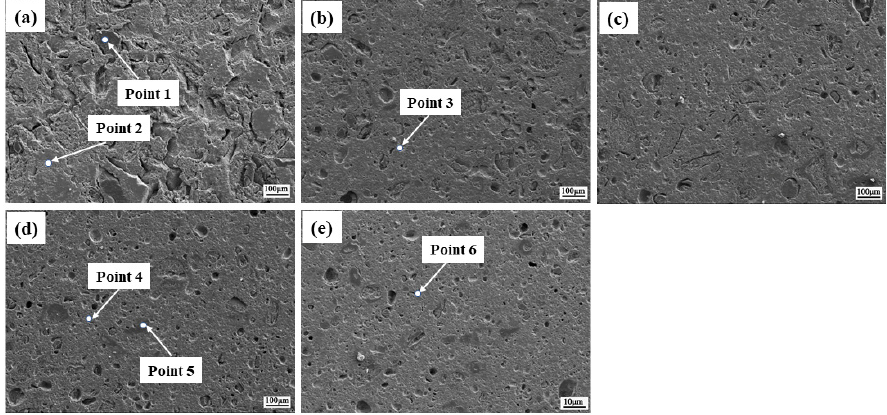
Figure 11. SEM analysis of Fe 2 O 3 -MgO sample after reduction. ( a ) 0% ( b ) 25% ( c ) 50% ( d ) 75% ( e ) 100%.